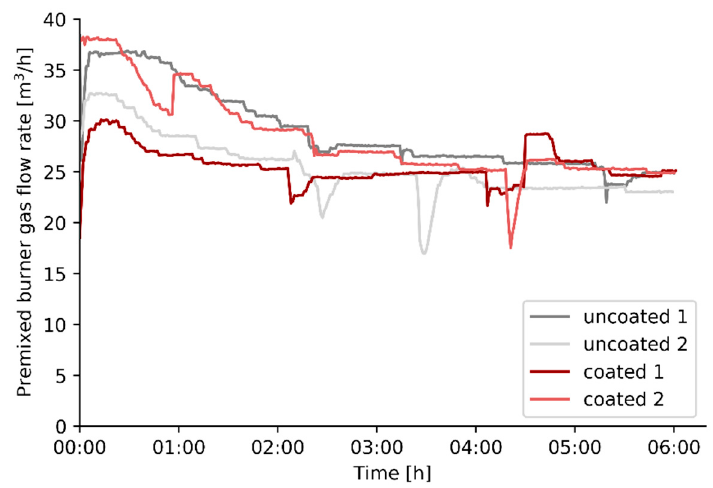
Figure 9. Premixed burner gas flow rate to cells 3 and 4 combined versus time for the different experiments.